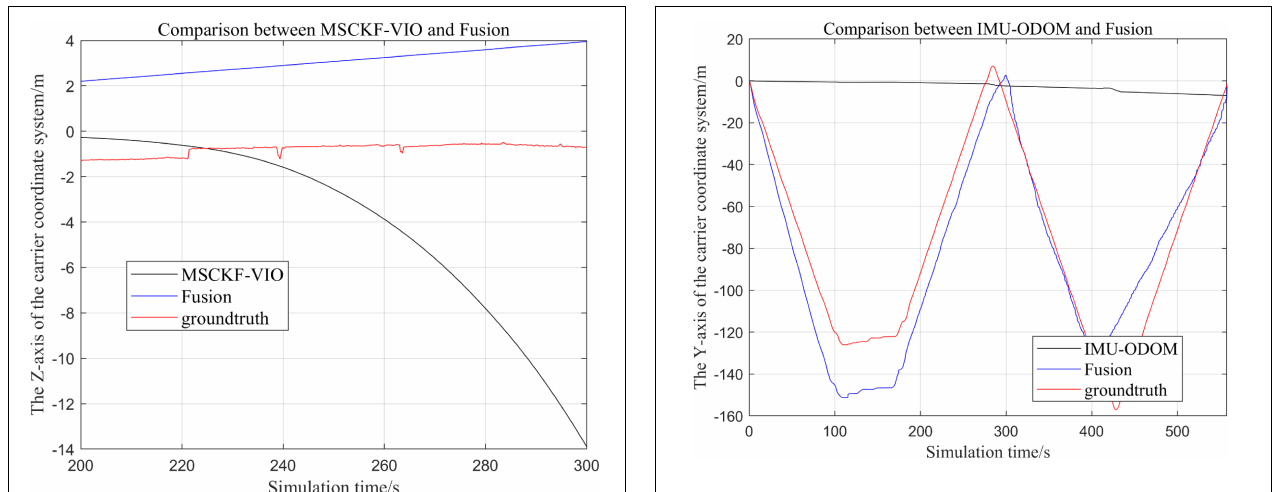
FIGURE 11 | Overall trajectory comparison of fusion algorithm with IMU and ODOM fusion algorithm in y -axis.